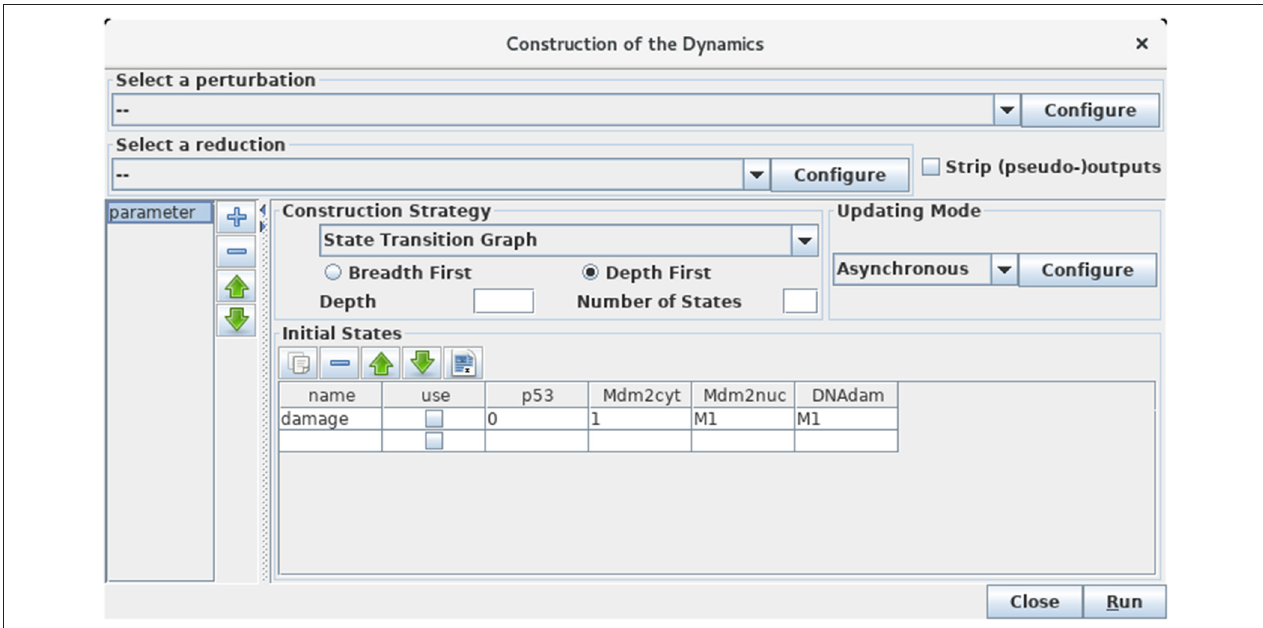
FIGURE 5 | Launching of the construction of a state transition graph. This panel is obtained when selecting Run Simulation from the Tools scrolling menu in GINsim main window. The default simulation settings are shown, i.e., the construction of a state transition graph using the asynchronous updating, with no specified initial state (meaning that all states are considered in the simulation). Hitting the Run button will generate the corresponding state transition graph, which can be displayed in a new window (see Figure 6 ). In the table under Initial States , one can define one or several initial states from which the dynamics will be constructed (just type the desired values in a row along with an optional name). Each row of the table defines a single pattern of states, and the check-boxes allow to select the states to be used for a simulation. The levels are specified for each node in the corresponding table cell. Nodes for which values are left free are denoted by stars (*). Initial states can be reordered, deleted and duplicated using the buttons just above the table. Here, a unique initial state has been defined, but not selected for simulation: the state 0111 (i.e., with p53 set to 0, and the three other nodes set to 1). Note that M1 emphasizes the fact that the value 1 is the maximal level for Mdm2nuc and for DNAdam. Several parameter configurations can be created and stored using the + button on the left